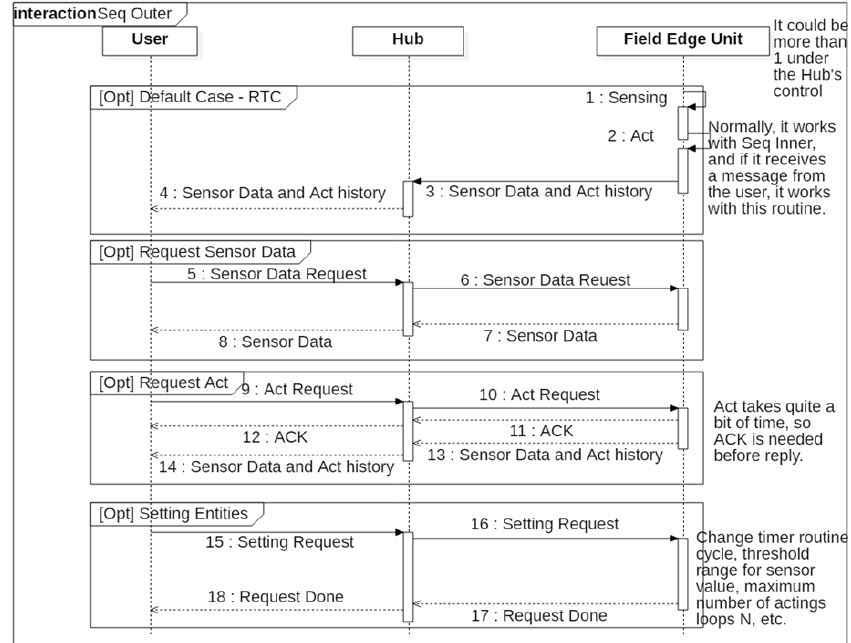
Figure 8. Event sequence of Field Edge Unit.